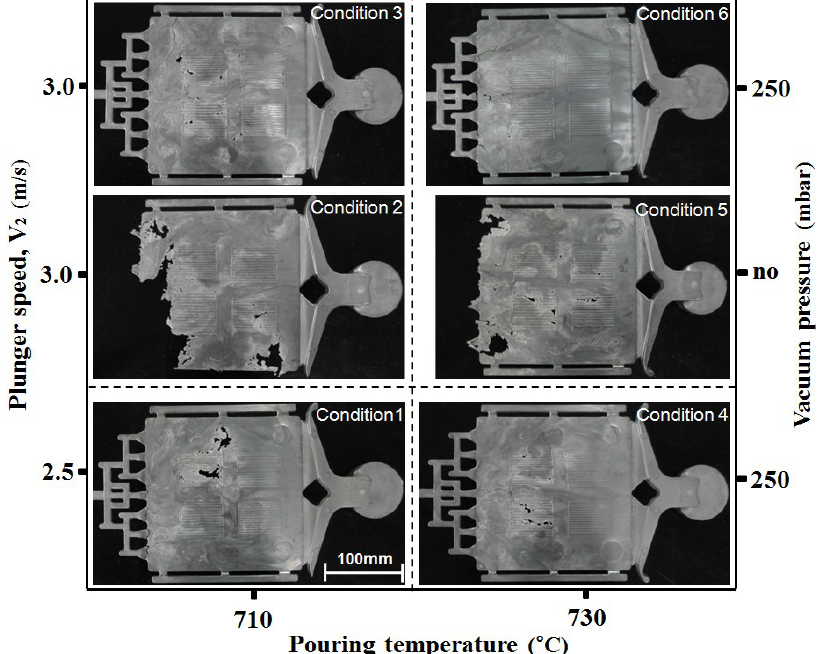
Figure 5. Samples fabricated by vacuum die casting with different parameters: Condition 1 ( T = 710 °C, V 2 = 2.5 m/s, P vacuum = 250 mbar); Condition 2 ( T = 710 °C, V 2 = 3.0 m/s, no vacuum); Condition 3 ( T = 710 °C, V 2 = 3.0 m/s, P vacuum = 250 mbar); Condition 4